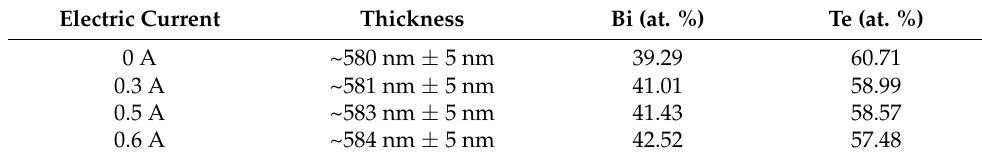
Table 1. SEM-EDS results of Bi 2 Te 3 f-TF.